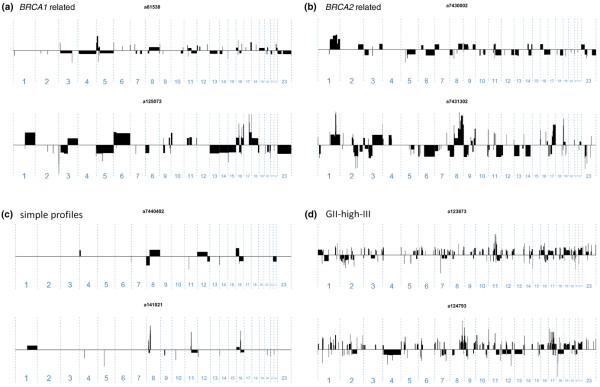
Differences in genome architecture patterns were observed between the identified subgroups. Two tumour genomes are shown for each of the four subgroups. (a) The BRCA1- and (b) BRCA2-related subgroups are characterised by relatively long segments of deletions with occasional high-level amplifications. (c) The simple-profile subgroup resembled the BRCA1- and BRCA2-related subgroups but displayed considerably less complex genomes. (d) The GII-high-III subgroup was characterised by small and closely spaced segments of genomic alterations throughout their tumour genomes along with occasional high-level amplifications. GII = genomic instability index.